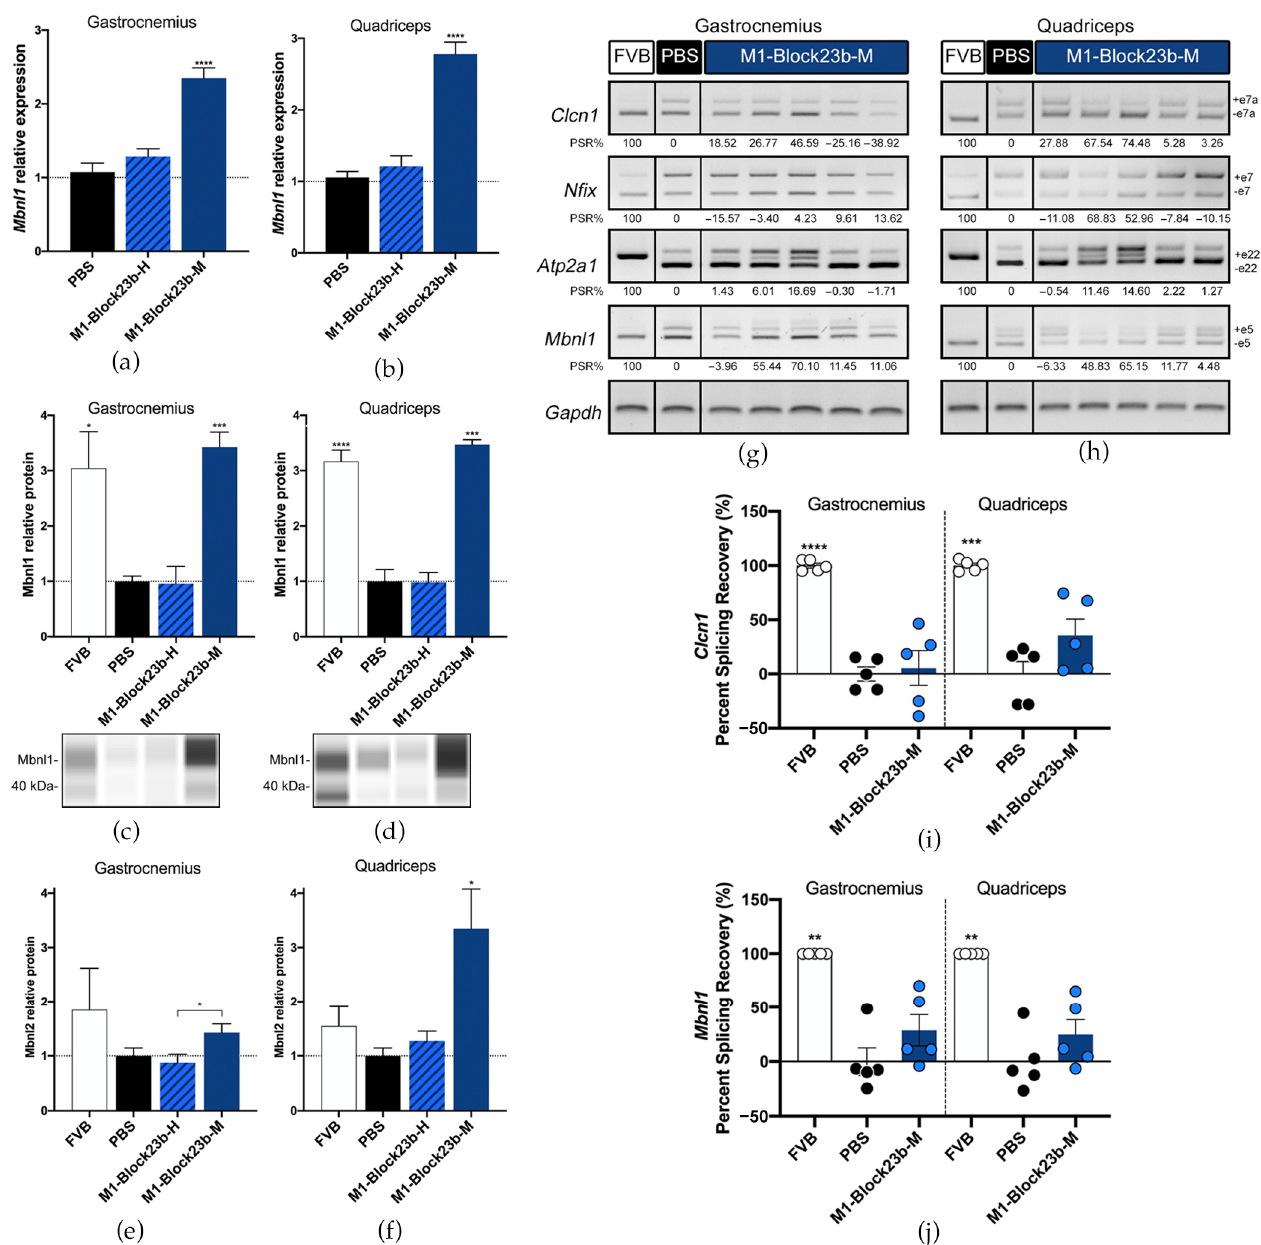
Figure 6. Molecular rescue by blockmiR in mice. Relative expression of Mbnl1 transcripts in ( a ) gas- trocnemius and ( b ) quadriceps muscles was relatively quanti fi ed with three technical replicates from each mouse after treatment with the blockmiRs. The data were normalized to Gapdh as an endogenous control. ( c , d ) Jess Simple Western technology was used to relatively quantify Mbnl1 protein for each muscle. Bands from a representative lane view can be seen below each graph. ( e,f ) Mbnl2 was quanti fi ed through sandwich ELISA and the average of three technical replicates was normalized to total protein from BCA quanti fi cation. Alternative splicing was analyzed for transcripts Atp2a1 , Clcn1 , Mbnl1 , and N fi x with Gapdh used as an endogenous control. A representative gel is seen above for ( g ) gastrocnemius and ( h ) quadriceps. Amplicons were generated using three di ff erent cDNA replicates and averaged for statistical analysis using Image J. The quanti fi cation can be seen in the percent splicing recovery (PSR%) noted below each band. The same data represented in a sca tt er plot is presented in panel ( i ) for Clcn1 and ( j ) for Mbnl1 . All statistical comparisons were performed against PBS via Student’s t-test. p -value: p ≤ 0.05 (*), p ≤ 0.01 (**), p ≤ 0.001 (***), p ≤ 0.0001 (****). Error bars = SEM. Reproduced/adapted from [29] Universitat de València, 2022. 4. Discussion